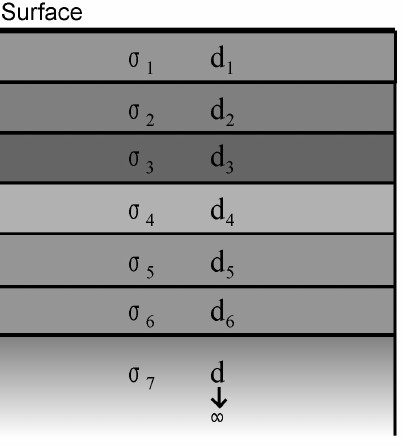
Fig. 2. Layered conductivity model for the Earth beneath the Nor- man Wells – Zama pipeline.